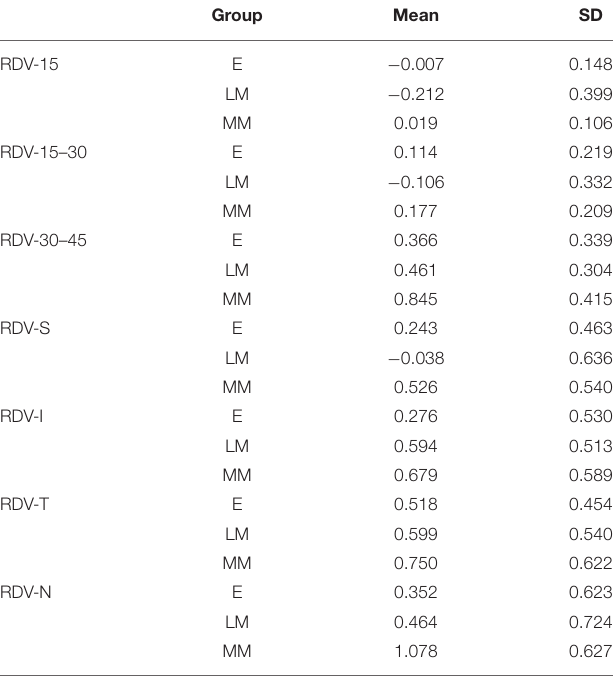
Frontiers in Medicine |